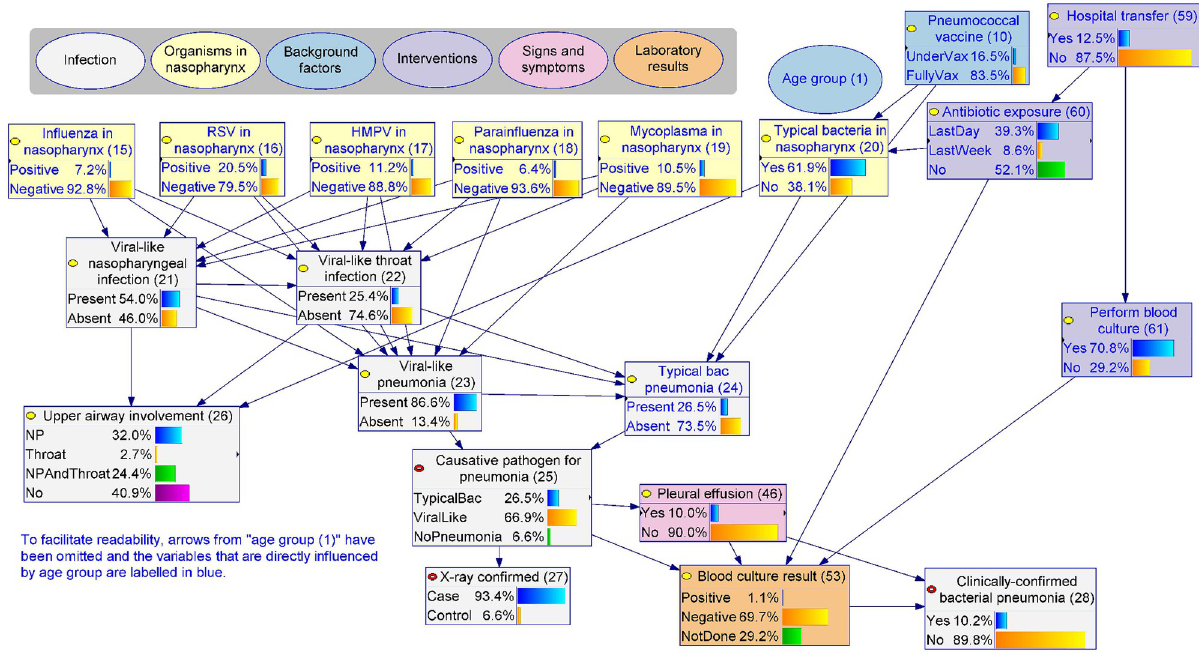
Fig 5. The infection, BN v4.5. The detailed model structure and definition for each variable are provided in S1 Table. Source model files can be accessed via Open Science Framework